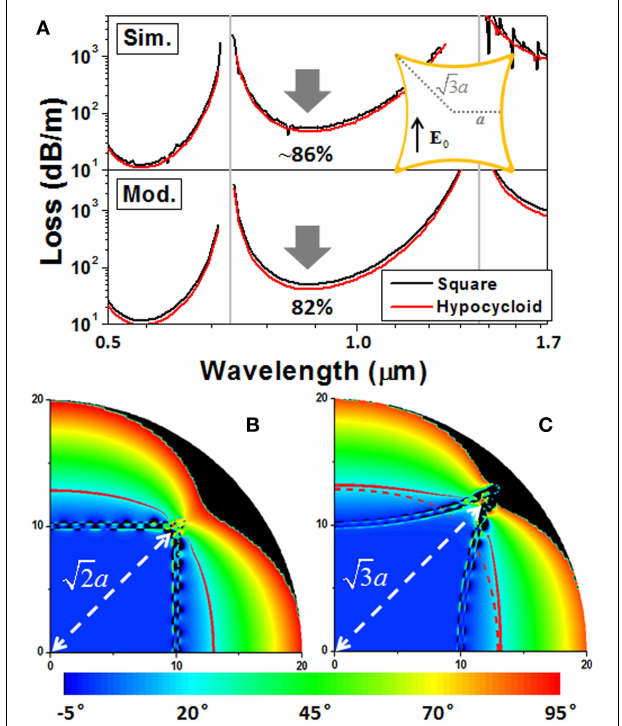
FIGURE 7 | (A) Simulated and modeled attenuations of a single-wall square ARF (the black lines) and its hypocycloidal variant (the red lines). (B,C) Phase distributions of these two fibers. The phases at fiber’s central axes (0, 0) are set to 0 ◦ , and the dark red lines represent the contours of 20 ◦ . The dashed dark red line in (C) is a copy of the dark red line in (B) . a 0.67 µ m, and λ 0 0 . 91 µ =